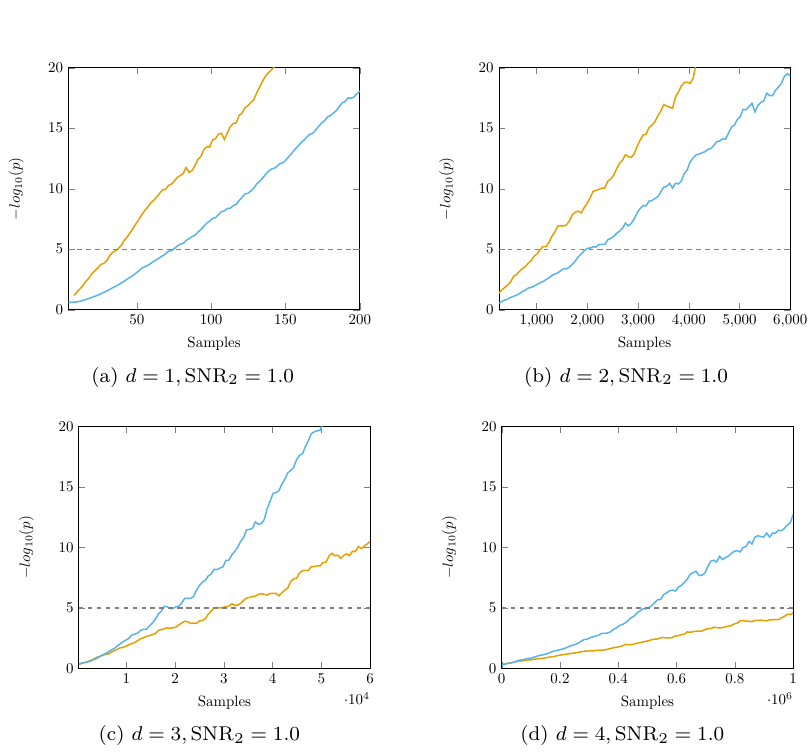
Figure 3: Performance of the (orange) t -test and (blue) χ 2 -test for simulated univariate 1st-, 2nd-, 3rd-, and 4th-order leakage with SNR 2 = 1 .